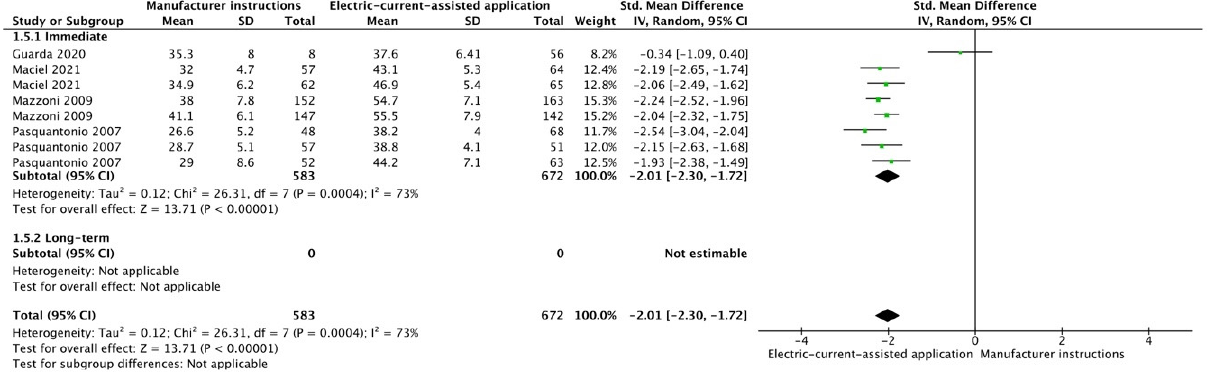
Figure 6. Forest plot showing the bond strength values when the adhesive was used in an active application.